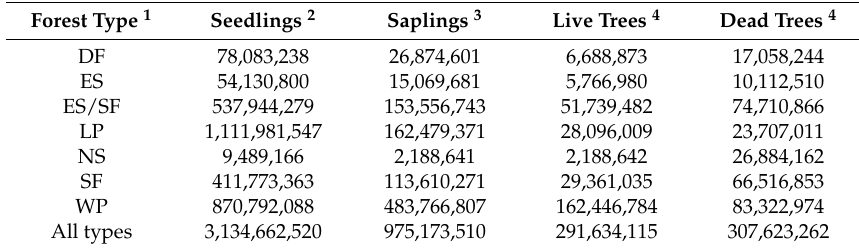
Table 3. Population estimates of the number of whitebark pine trees by major forest type in the western US. Forest types whose whitebark pine component covers <100,000 ha are not shown but included in total (“All